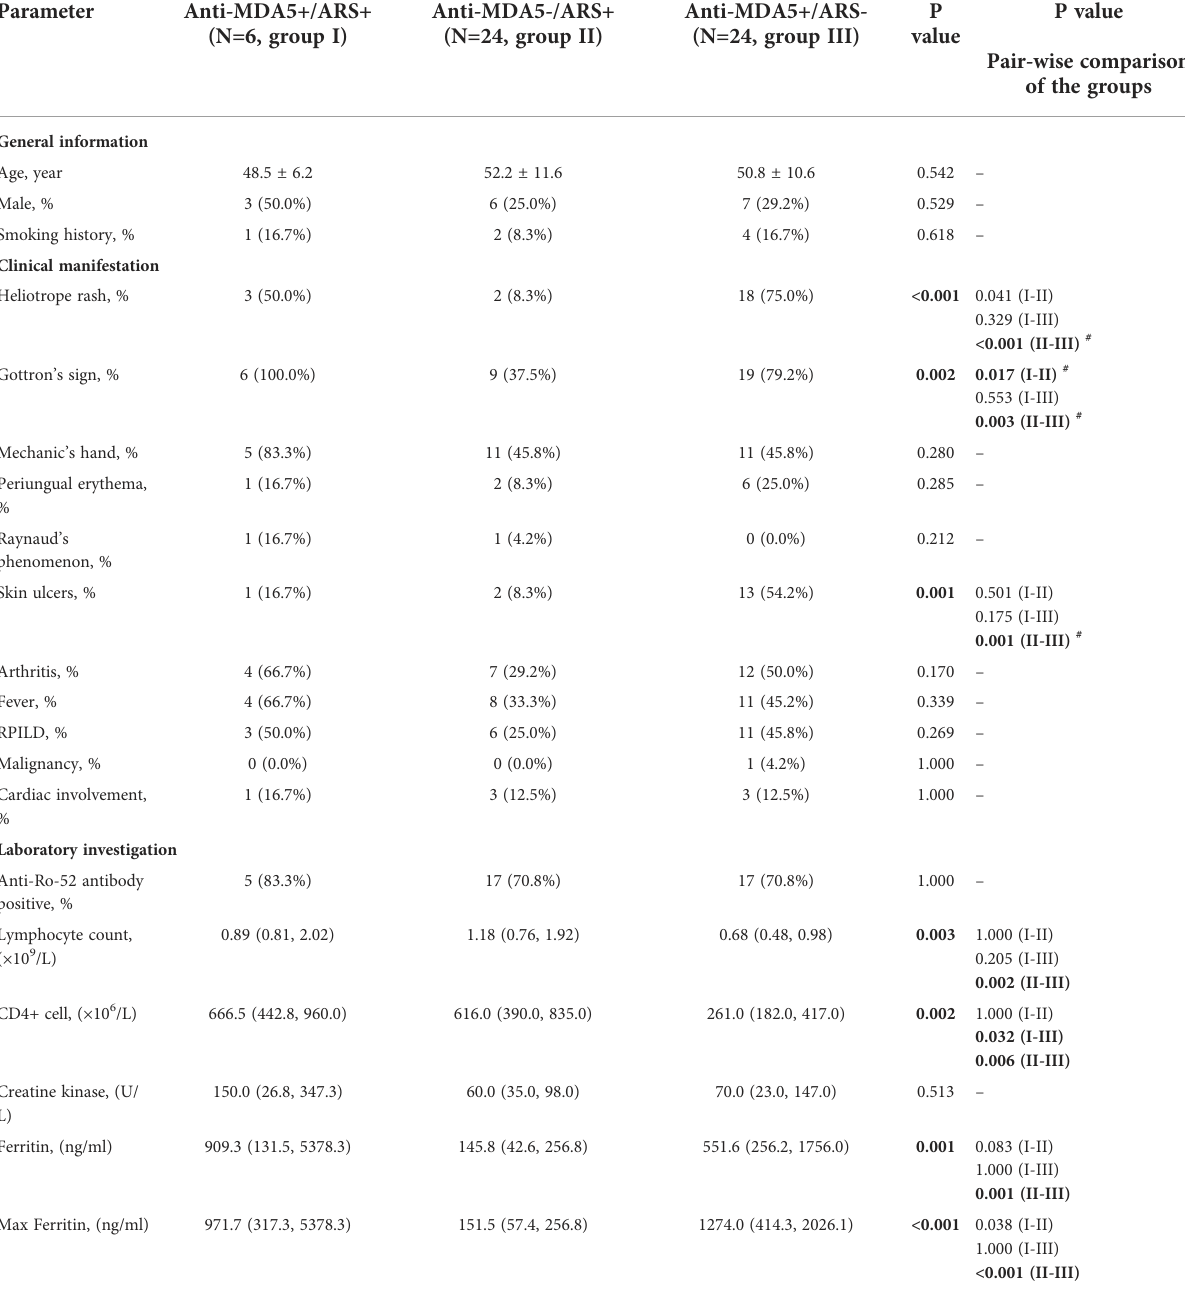
TABLE 2 Comparison of clinical manifestations in different groups (anti-MDA5+/ARS+, anti-MDA5-/ARS+ and anti-MDA5+/ARS-) of IIM patients .